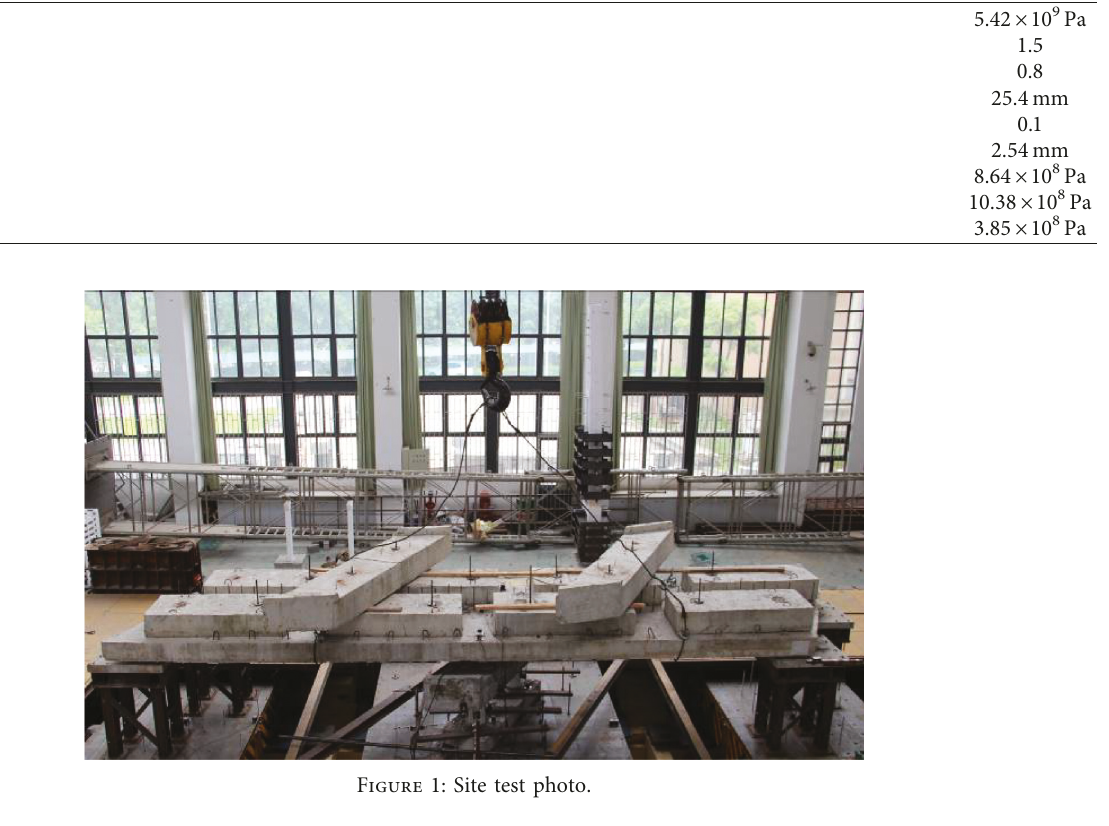
Figure 1: Site test photo.